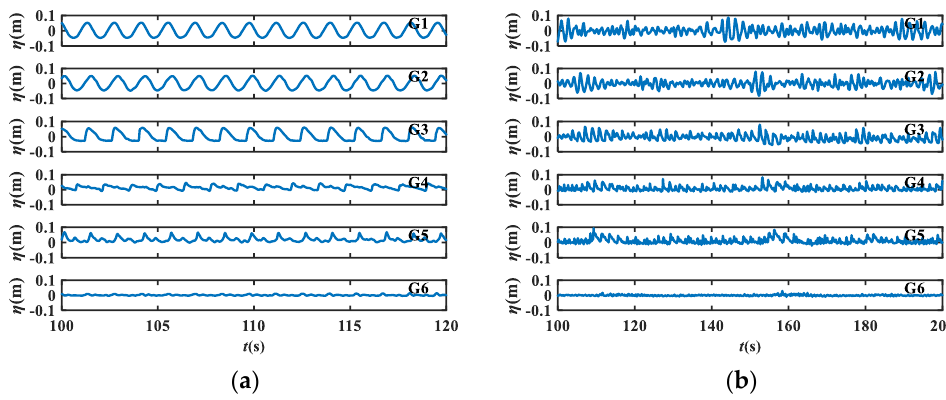
Figure 7. Time histories of free surface elevations for the vertical seawall for H 0 = 0.1 m ( H s 0 = 0.1 m), T 0 = 1.4 s ( T 0 = 1.4 s), cot θ = 3, l = 3 m, and h r = 0.05 m: ( a ) regular wave; ( b ) irregular wave.